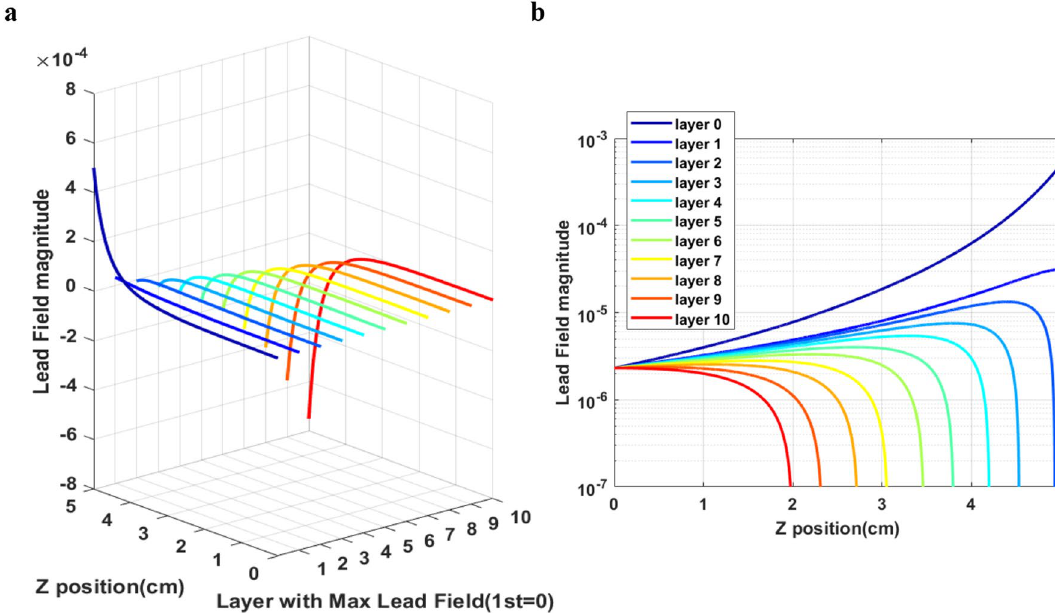
Figure 15. ( a ) Lead field magnitude with maximum at different Z layers and ( b ) lead field magnitude with maximum at different Z layers in two-dimensional